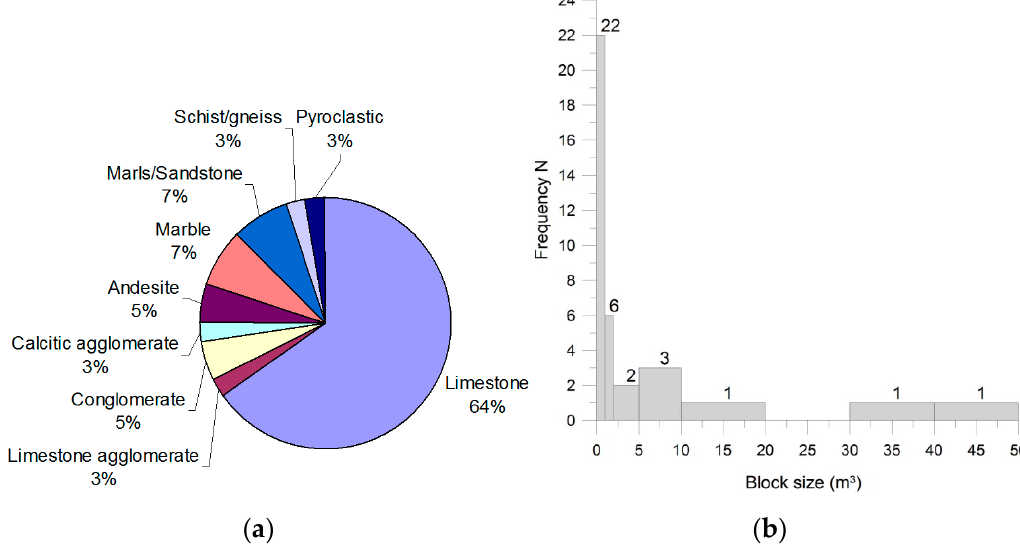
Figure 2. ( a ) Lithology in areas of rockfall events, ( b ) Frequency of block size of fallen rocks.